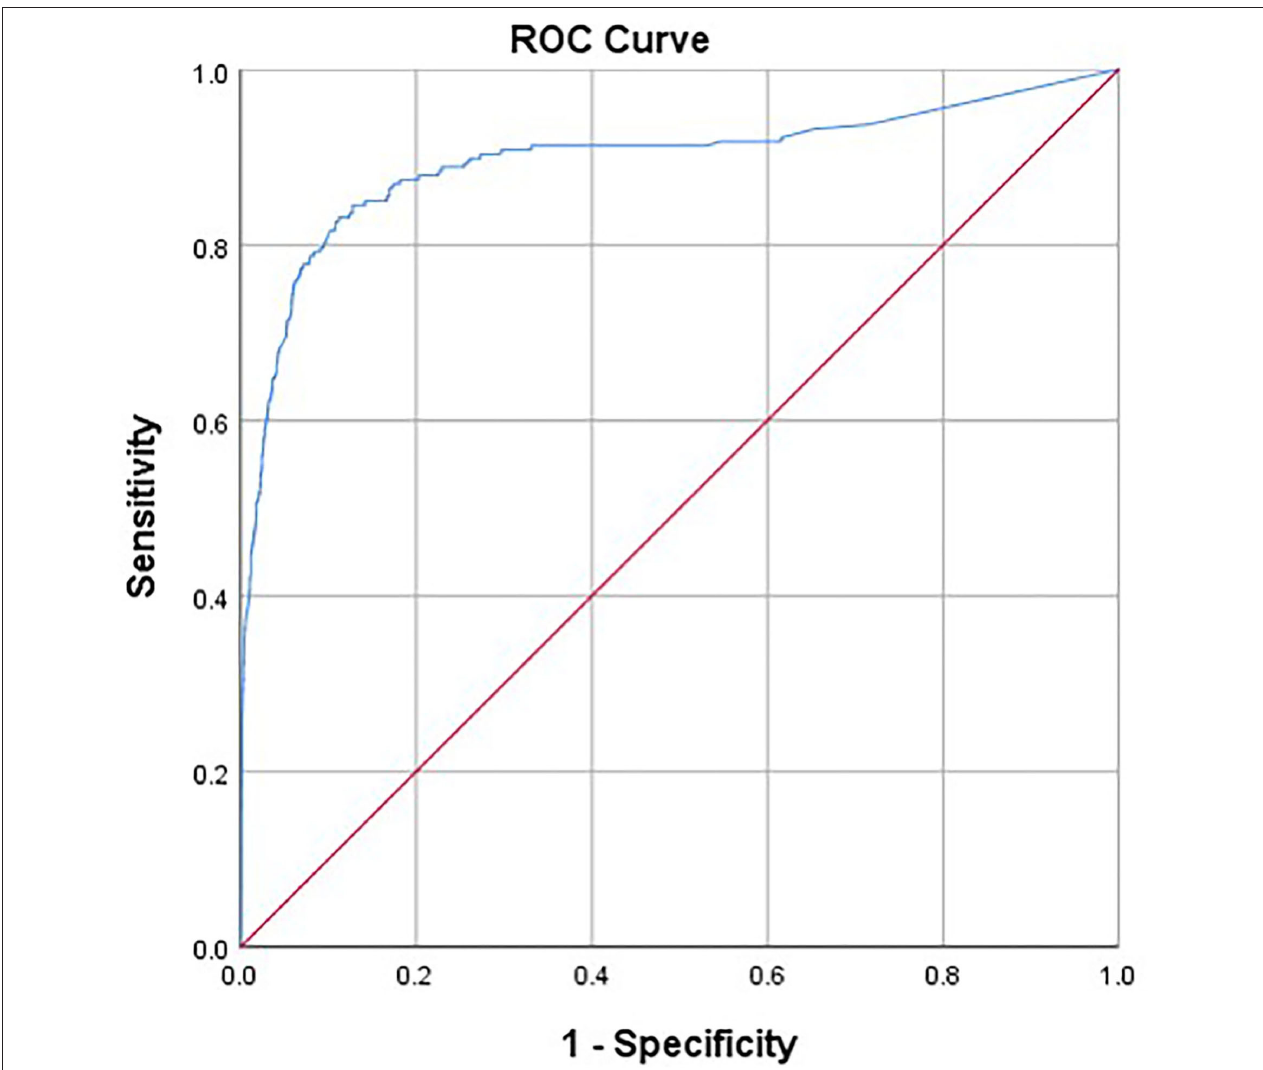
FIGURE 2 | Area under the ROC curve of the GDSQ-21 for diagnosis (AUC, 0.896). ROC, receiver operating characteristic; AUC, area under the ROC curve.